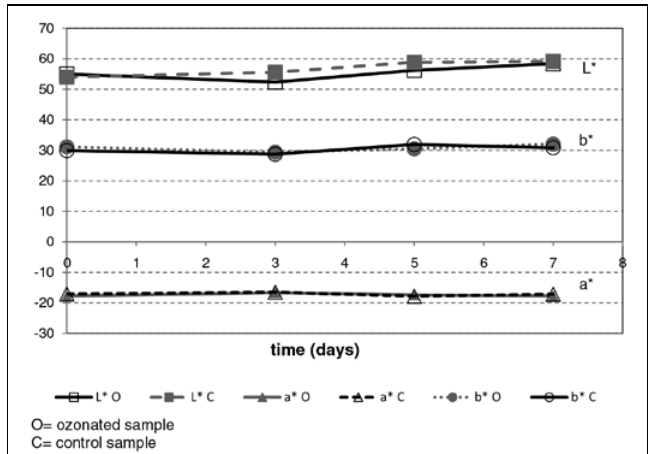
Fig. 6 - L*, a* and b* values determined on the lower leaf